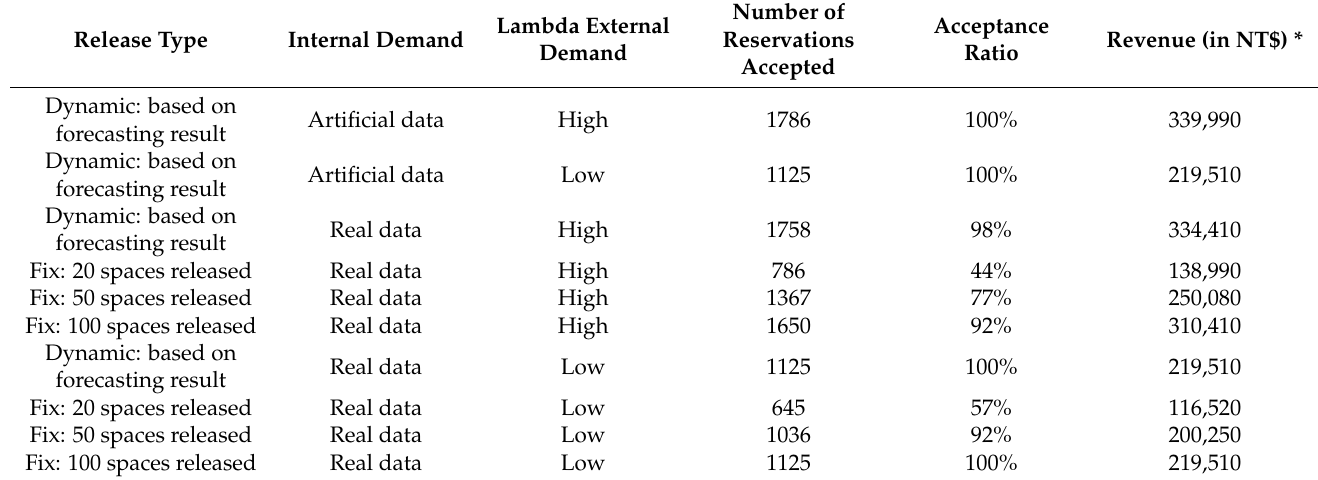
Table 10. Simulation